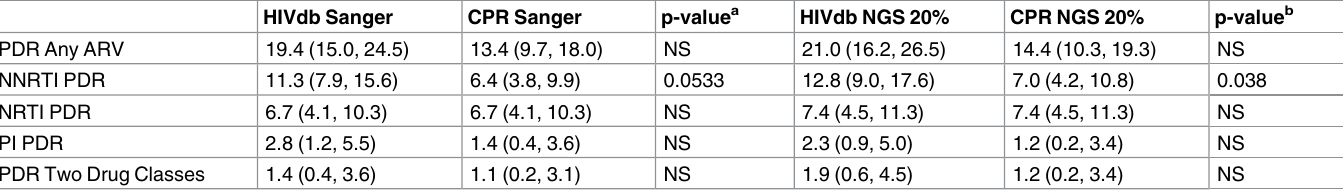
HIV pre-treatment drug resistance defined with Stanford HIVdb or Calibrated Population Resistance (CPR) tools for Sanger sequences and next generation consensus sequences (NGS) at 20% threshold. a